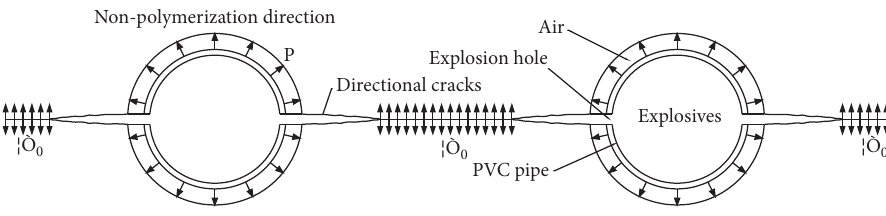
Figure 4: Directional energy gathering blasting.